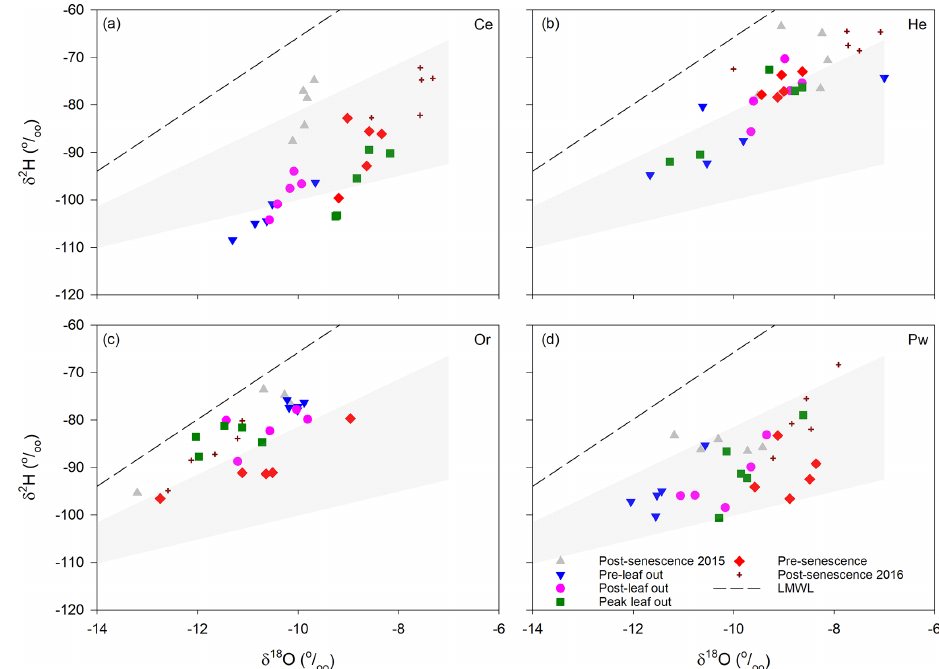
Figure 4. Xylem water isotopic composition for the different sampling periods for Ce (a) , He (b) , Or (c) and Pw (d) . LMWL – local meteoric water line. Shaded areas encompass the range (2.5–5) of evaporation line slopes originating from the most isotopically depleted snowmelt sample measured in 2016. Table 2. Significant differences in mean xylem water lc-excess for a given sampling period, determined from t tests with p = 0 . 0015 (equivalent to p = 0 . 05 following Bonferroni correction). Post- Pre-leaf Post-leaf Peak leaf Pre- Post- senescence out out out senescence